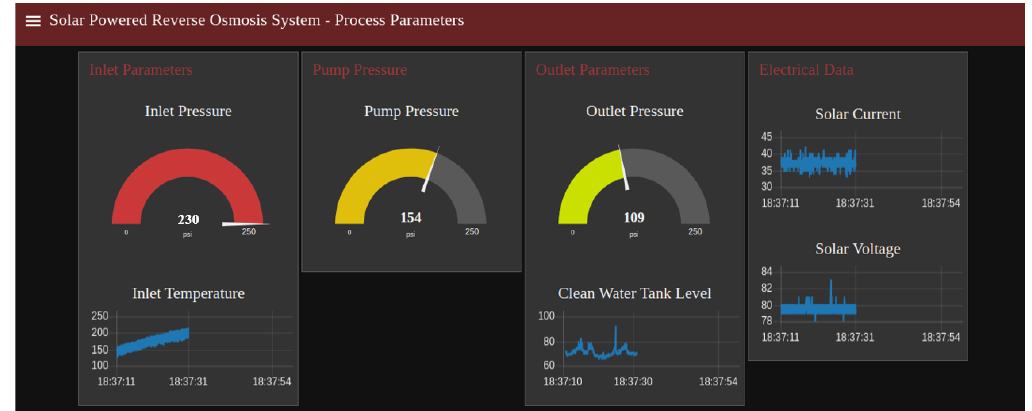
Figure 12. Node-Red Dashboard for real-time monitoring. In order to store the data on a local server, InfluxDb is used as the database, and tags of all process parameters were created. Figure 13 shows the database structure and tags generated in the system.